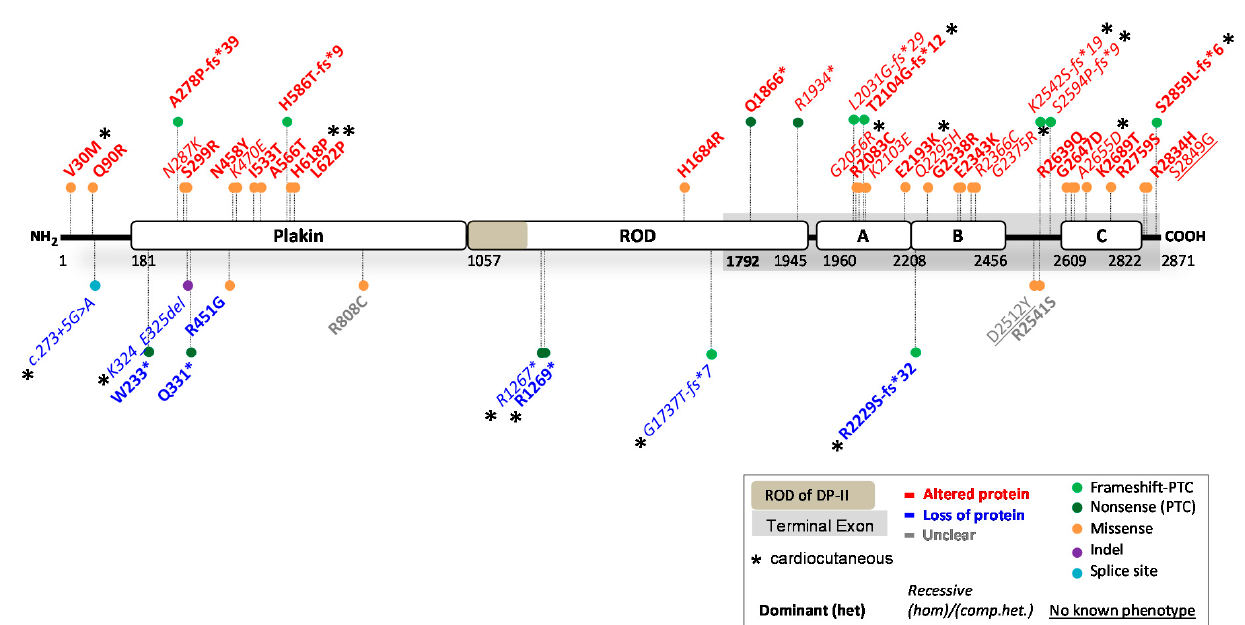
Figure 2. Location of functionally investigated DSP variants.